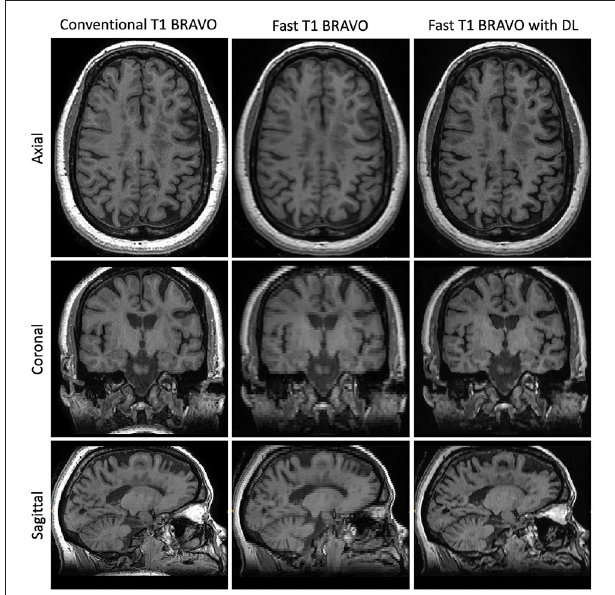
FIGURE 2 | Representative T1w images. Central slices in a similar position for the acquisitions using the three methods: Conventional T1w BRAVO (2:57min total acquisition time, 220 × 220 × 126 matrix size), fast T1w BRAVO (1:13min total acquisition time, 220 × 128 × 64 matrix size), and fast T1w BRAVO with DL (same acquisition time and matrix size as the fast T1w BRAVO). BRAVO is the T1-weighted sequence for brain volume imaging on GE MR